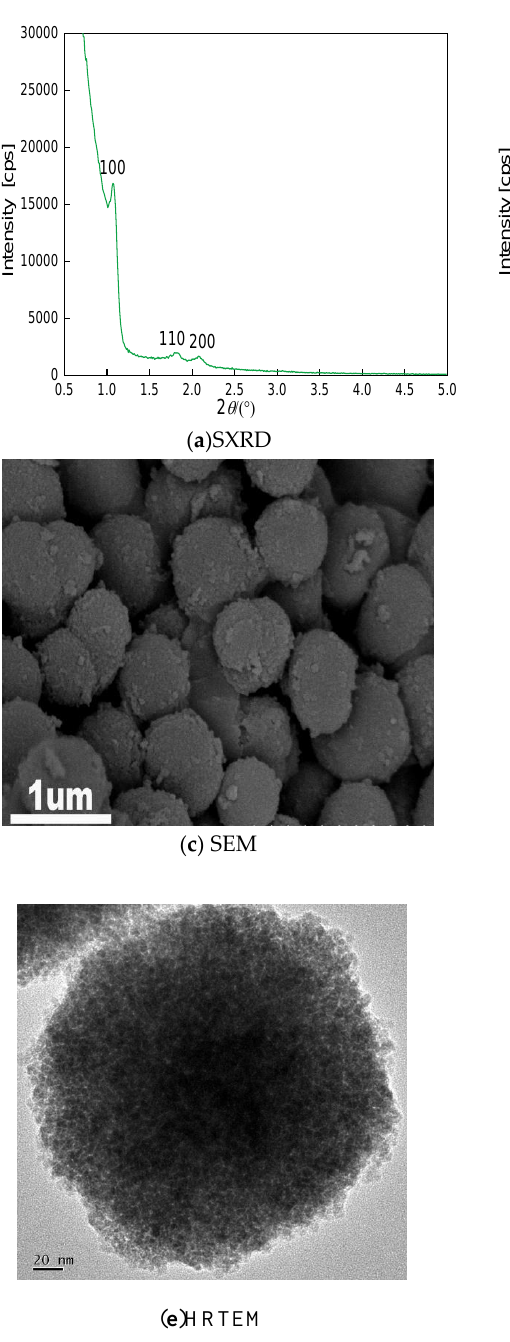
Figure 2. XRD, SEM and TEM and HRTEM photos of YSG.